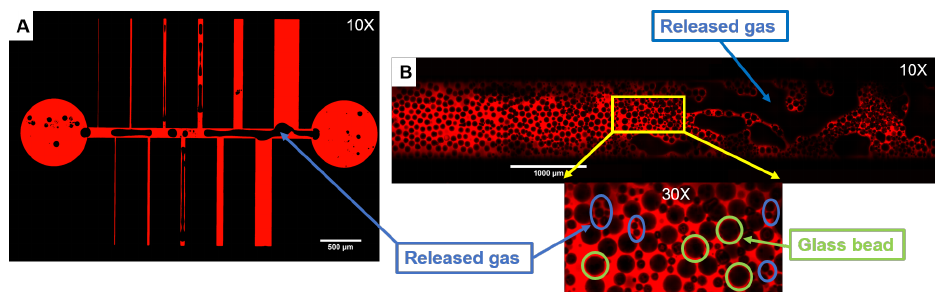
Figure 10. Confocal images of two types of the micromodels impregnated with resin under high pressure (65 bar) released to atmospheric pressure before complete curing took place. ( A ) Silicon micromodel, and ( B ) sintered glass beads. Defects in both models occurred when nitrogen gas dissolved at 65 bar was abruptly released when the pressure was dropped to atmospheric and the resin was incompletely cured. The gas release in model B was severe enough to debond some of the sintered glass beads.